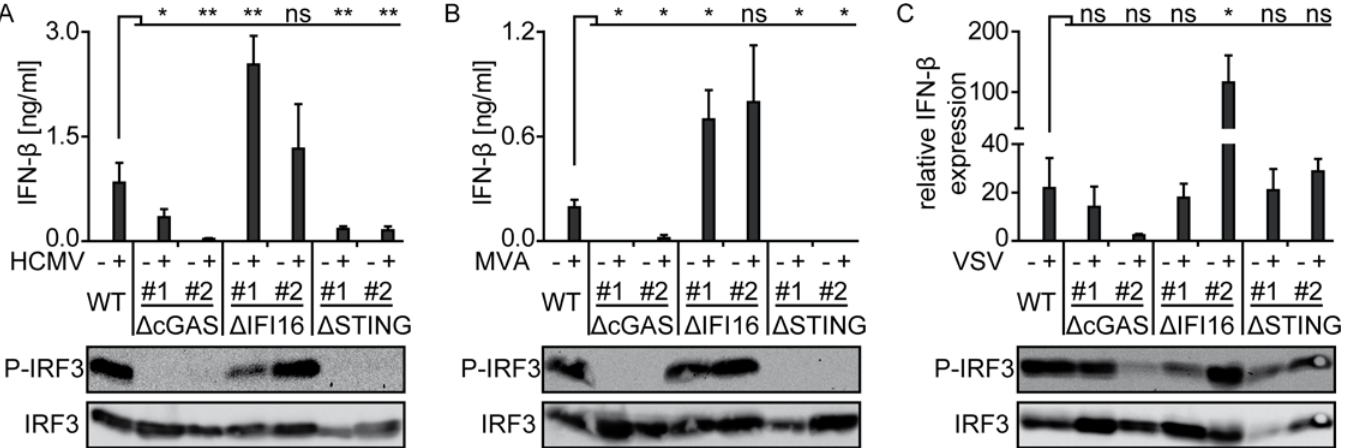
Fig 6. Upon HCMV stimulation PMA-matured THP-1 cells mount IFN- β responses in a cGAS-dependent manner. WT (wild-type), and 2 clones (#1 and #2) of cGAS, IFI16, or STING deficient THP-1 cells differentiated with PMA for 3 days were stimulated with (A) HCMV at MOI 10, (B) MVA at MOI 1, or (C) VSV at MOI 1 for 24 h. Cell-free supernatant was tested for IFN- β by an ELISA method (A, B), or cell lysates were tested for IFN- β mRNA expression relative to HPRT1 mRNA by qPCR (C). Lysates of virus infected cells were analyzed for phosphorylated IRF3 (P-IRF3) and IRF3 by western blot (A, B, C). Mean ± SEM of 3 – 6 (A), 3 (B), and 4 – 5 (C) data points from 3 (A, C) and 2 (B) independent experiments. * : p (cid:1) 0.05, ** : p (cid:1) 0.0076 one-tailed Mann- Whitney